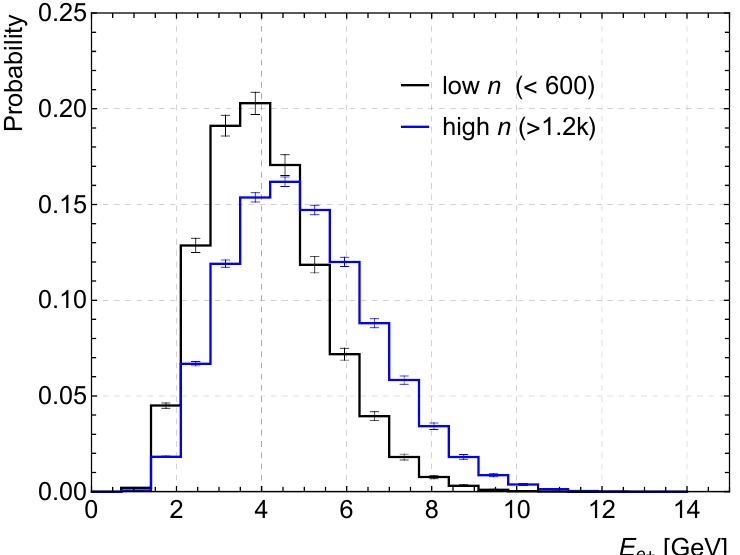
Figure 4. Energy histogram of low n events (black) ranges over lower energy bins than the energy histogram of high n events (blue). This is an analysis of the MC